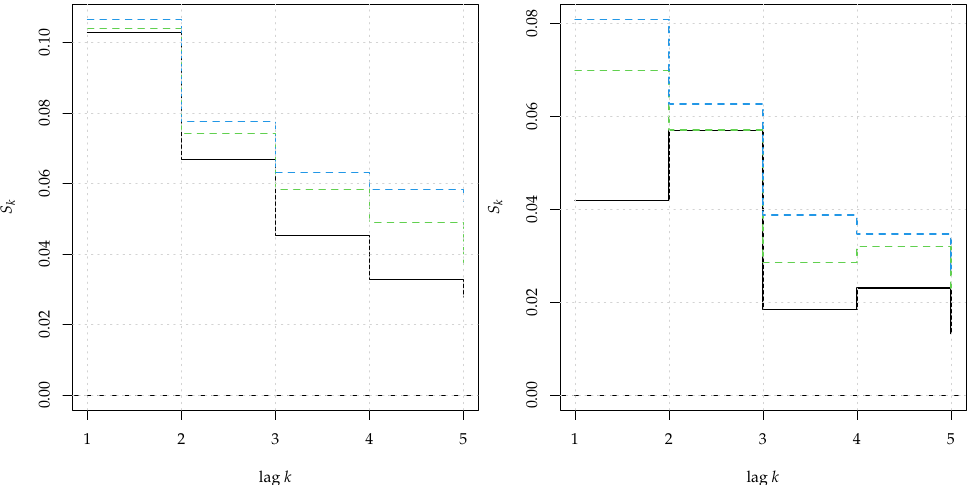
Figure 15. Serial entropy S k for k = 1, . . . ,5 (black, solid line), computed on a realization of a linear ARMA(1,1) process (left panel) and on the residuals of a fitted MA(1) model upon the series. The rejection bands at 95% (green dashed line) and 99% (blue dashed line) corresponded to the null hypothesis of a general linear